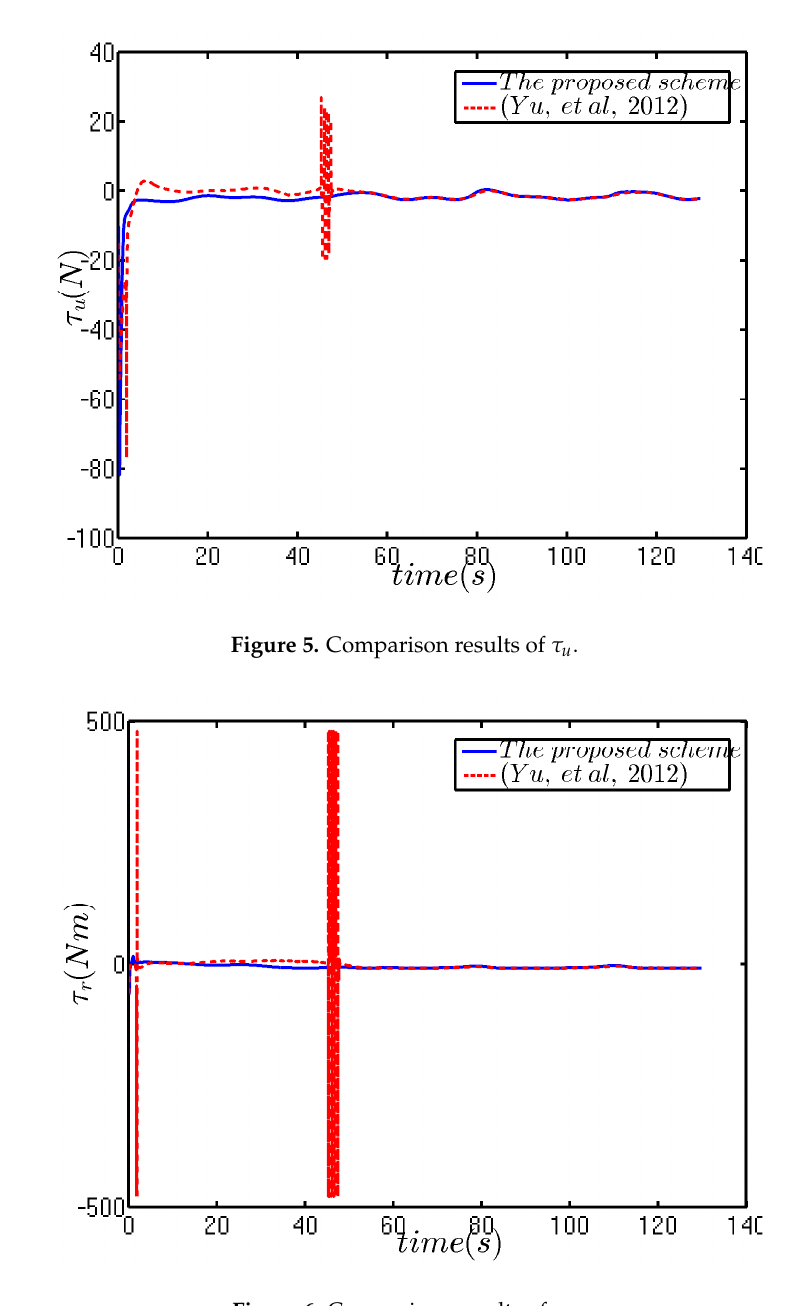
Figure 6. Comparison results of τ r